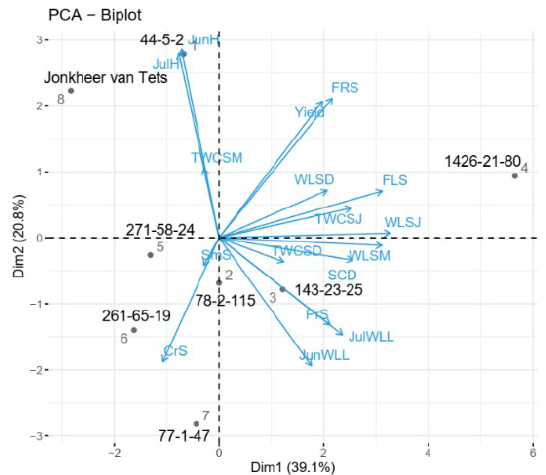
Figure 7. PCA—biplot with loadings analysis of red currant genotypes. Abbreviations: SCD: Signs